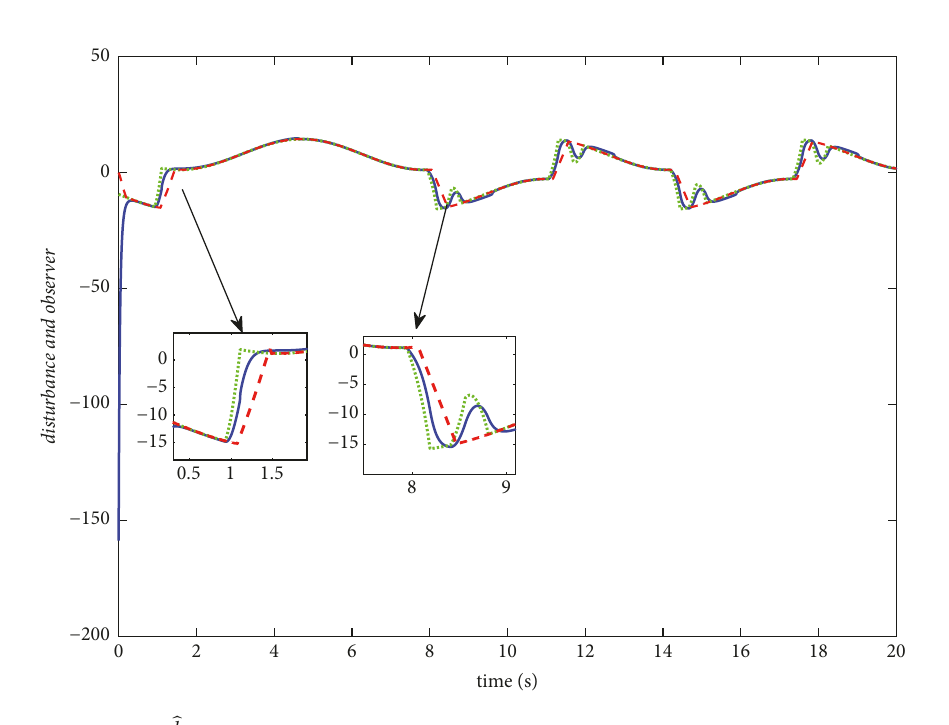
Figure 7: Adapt law.